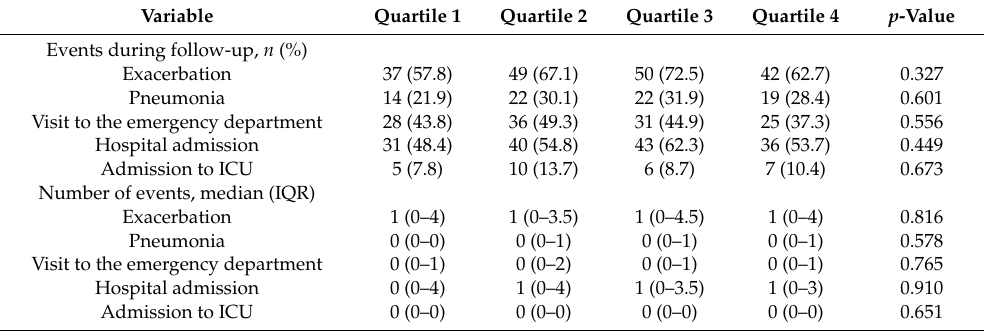
Table 4. Exacerbation, pneumonia, and use of health resources during follow-up according to BMI quartiles.